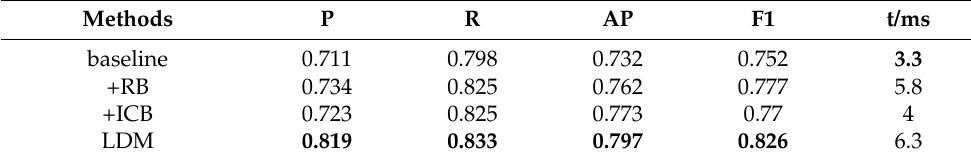
Table 3. Effectiveness of the proposed